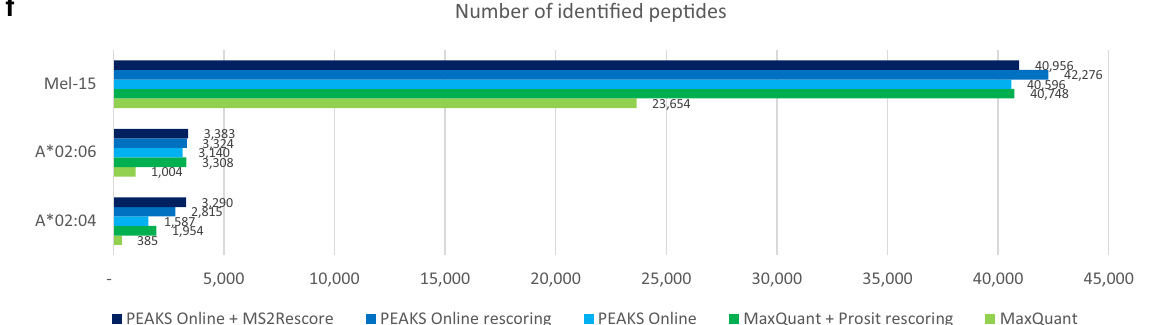
Fig. 1 PEAKS Online: an ultra-sensitive and streamlined platform for DDA and DIA mass spectrometry. a An overview of data acquisition strategies, analysis approaches, and core algorithms of the platform. b An example integrated work fl ow for DIA data analysis on the platform. c – e Performance evaluation of PEAKS Online, DIA-NN, and Spectronaut on three DIA benchmark datasets: Muntel et al. 31 , Xuan et al. 32 , and ABRF study 33 . f Performance evaluation of PEAKS Online, MaxQuant, Prosit, and MS 2 Rescore on three DDA immunopeptidomics datasets: Mel-15 from Bassani-Sternberg et al. 14 ; A*02:04 and A*02:06 from Sarkizova et al. 36 . (DDA: Data-Dependent Acquisition; DIA: Data-Independent Acquisition; FDR: False Discovery Rate; ALC: Average of the Local Con fi dence score; POL: PEAKS Online; ABRF: Association of Biomolecular Resource